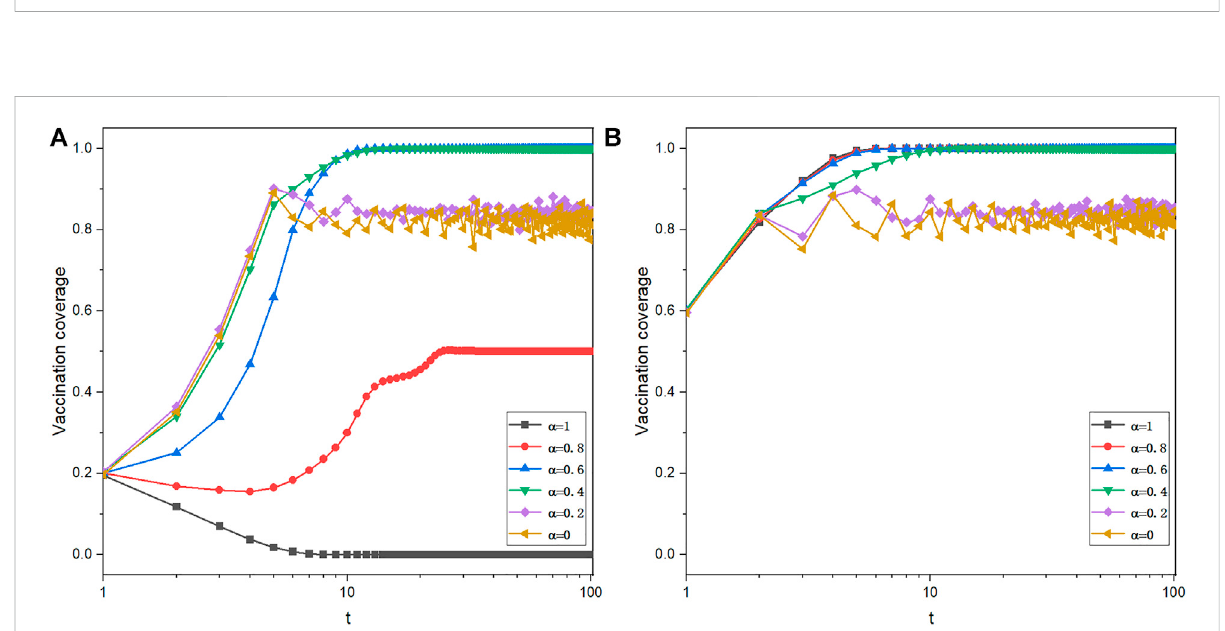
FIGURE 2 Time courses of vaccination coverage for V 0 = 0.2 (A) and V 0 = 0.6 (B) . Depicted results are obtained for γ = 0.8, K = 0.1, C V = 0.3, and C H =